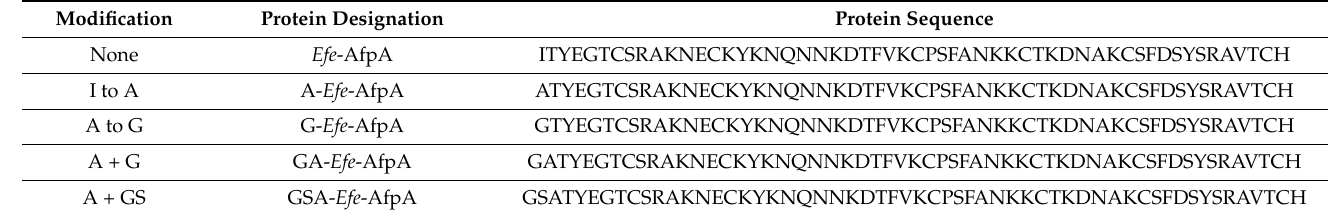
Table 1. N-terminal modifications of mature Efe -AfpA expressed in E. coli